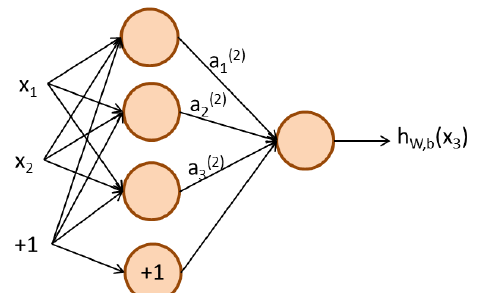
Figure 2. Diagram denoting a neural network with 2 input units ( x 1 and x 2 not counting the bias unit), an hidden layer (composed of 3 hidden “neurons”) and 1 output unit ( x 3 ). a i(l) is the output value (also called activation) of the neuron i in layer l and given a set of the parameters W,b the neural network defines a hypothesis h W,b ( x ) that outputs a real